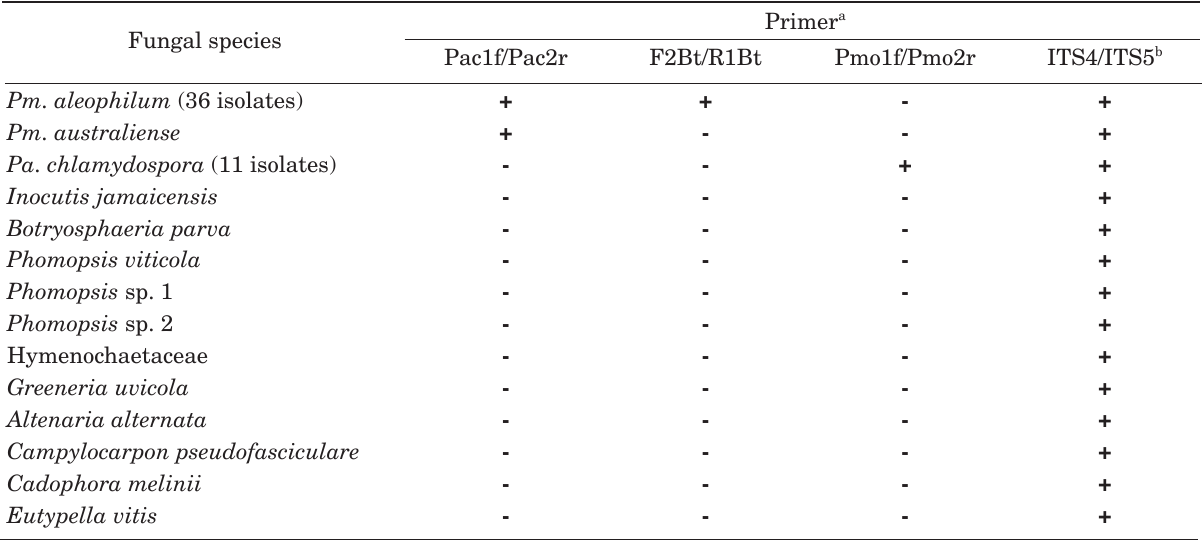
Table 2. PCR amplification of DNA from selected fungal species isolated from grapevines with specific primers for